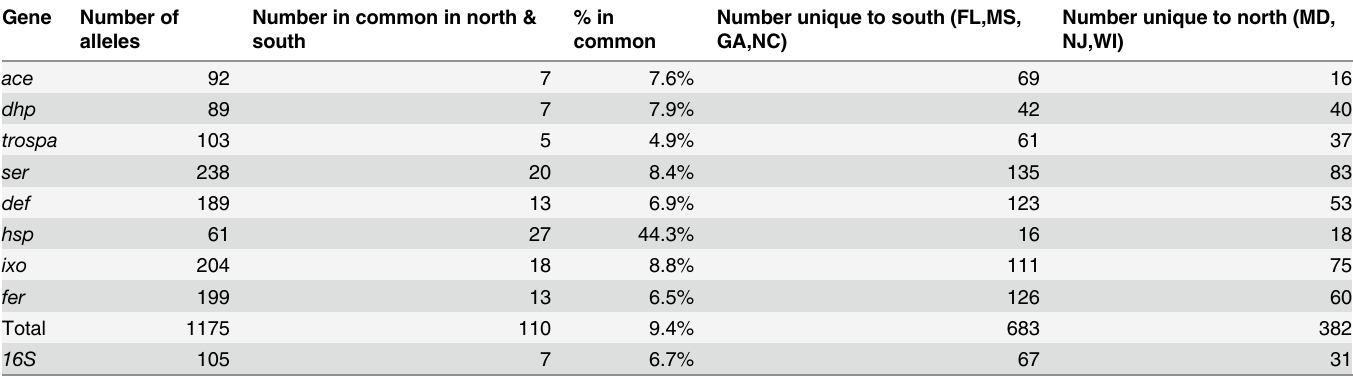
Table 3. Number of alleles at each gene (H from Table 2) and the number and percentage of alleles shared in common between and among north- ern (MD, NJ, WI) and southern (FL,MS,GA,NC) collections. The numbers of alleles unique to the north and to the south are listed.